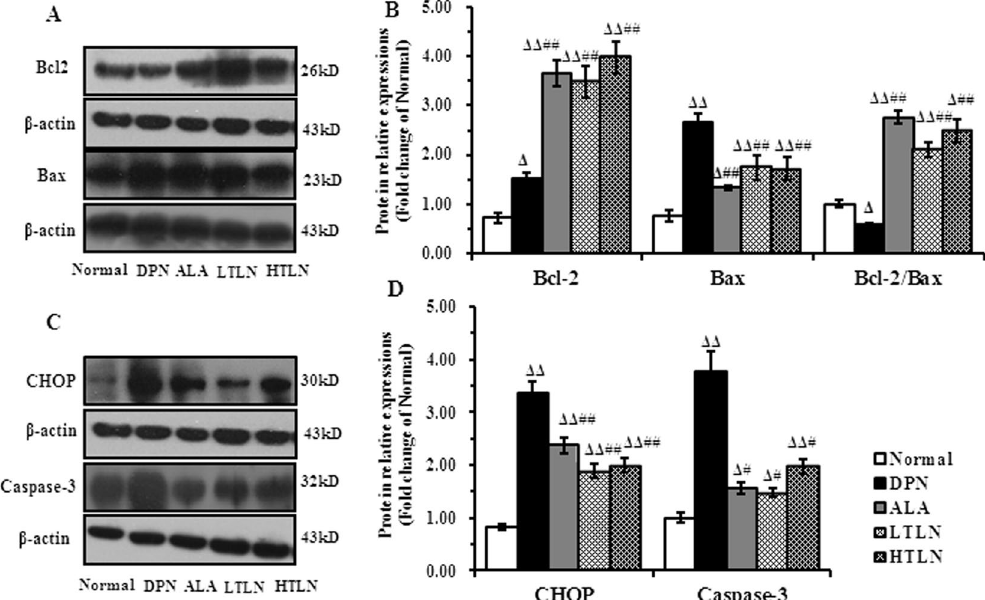
Figure 2. Downregulation of CHOP, Bax, Caspase-3 and upregulation of Bcl-2 in sciatic nerve of STZ-induced DPN rats by TLN treatment. ( A ) and ( C ) Representative Western blots of Bcl-2, Bax, CHOP and Caspase-3 12 weeks after TLN treatment (Left panel). ( B ) and ( D ) The relative levels of Bcl-2, Bax, CHOP and Caspase-3 (Right panel). Data are shown as mean ± S.E.M. Δ P < 0.05, ΔΔ P < 0.01 vs. Normal group; # P < 0.05, ## P < 0.01 vs. DPN group. Data were analyzed by One-way ANOVA followed by least significant difference or Tambane’s T2 analysis (n = 6 animals per